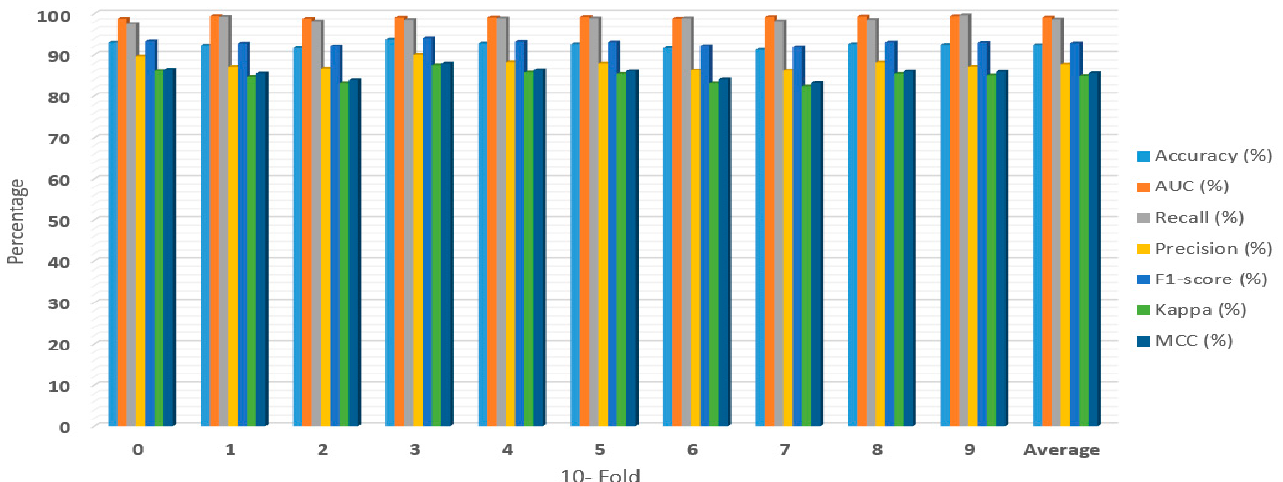
Figure 6. The metrics of the RF model after tuning the hyper-parameters.